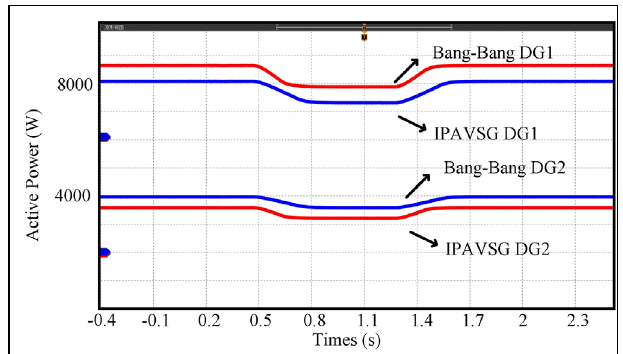
FIGURE 14 | Active power outputs from IIDG1 and